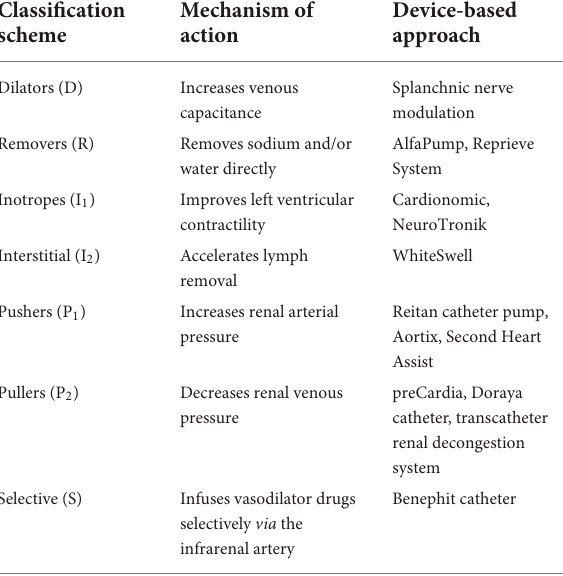
TABLE 1 DRI 2 P 2 S classification scheme for device-based therapy for heart